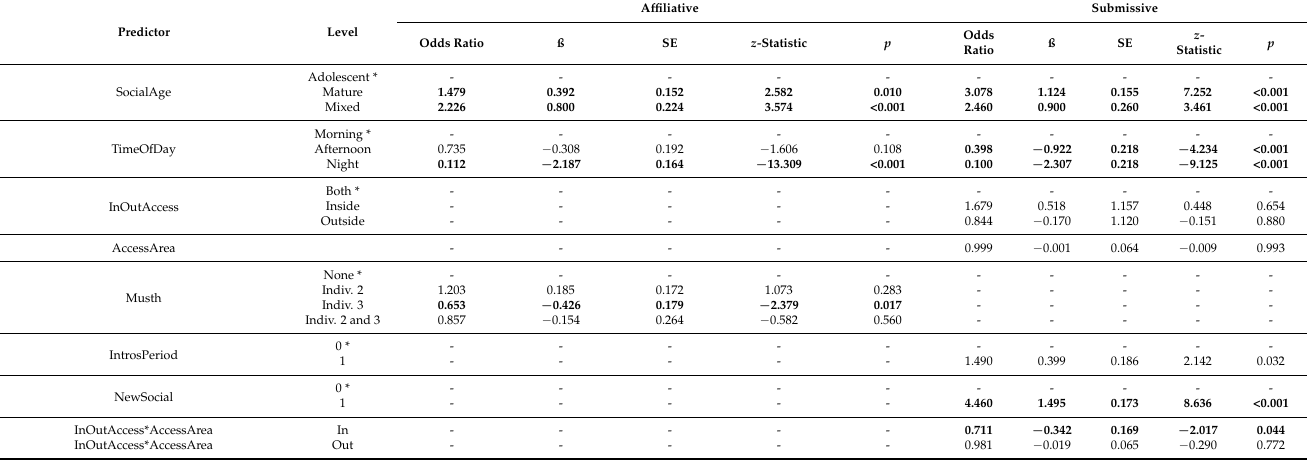
Table A4. Adolescent GLMER model parameter estimates for affiliative and submissive response variables. Generalized linear mixed-effect model results of associations between predictor variables (fixed effects) and behavioral response variables for adolescent focal animals. ß = Beta coefficients from model outputs: positive values indicate an increase in odds compared to the reference level while negative values indicate a decrease in odds compared to reference level; SE = standard error of beta coefficients; Wald X 2 = Chi-squared statistic from Wald test with df = 1; p = p -value from Wald test. * indicates reference level. Bold signifies statistical significance ( p < 0.05).